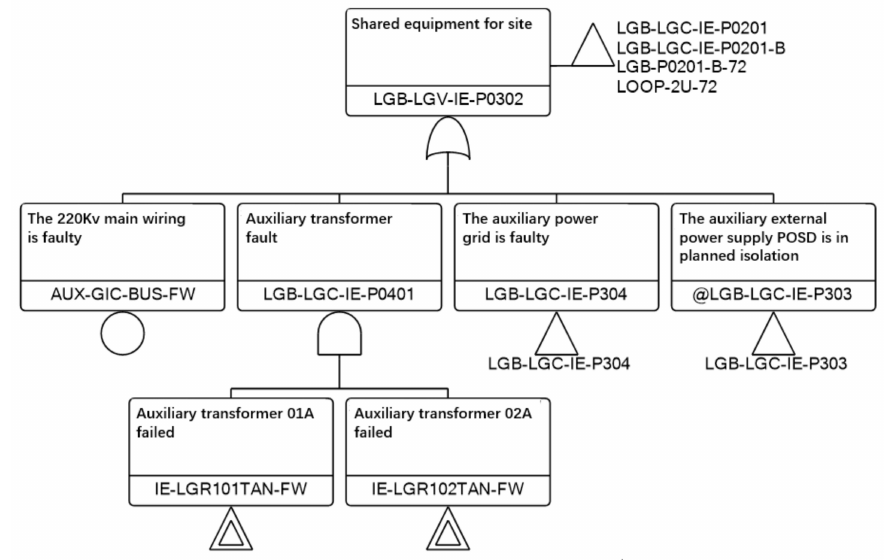
Figure 3. Fault tree of auxiliary external power supply